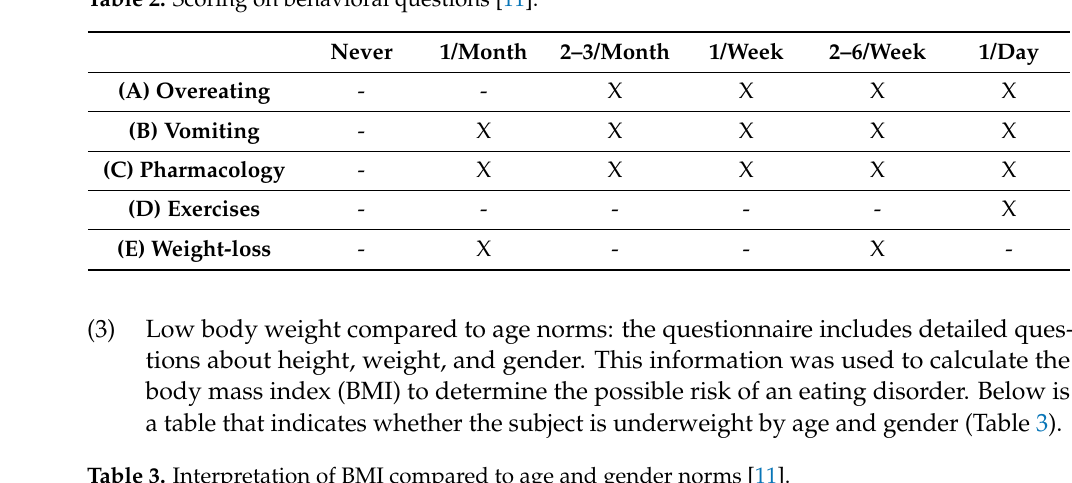
Table 2. Scoring on behavioral questions [11].